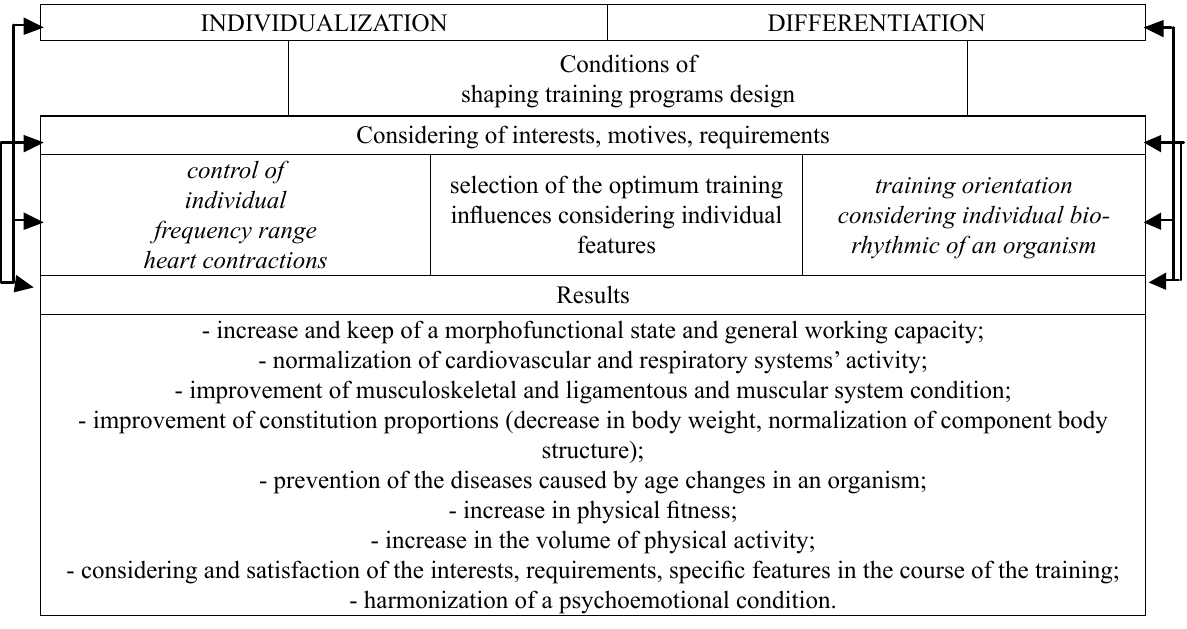
Fig. 1. The scheme of the individual differentiated technique design of improving shaping